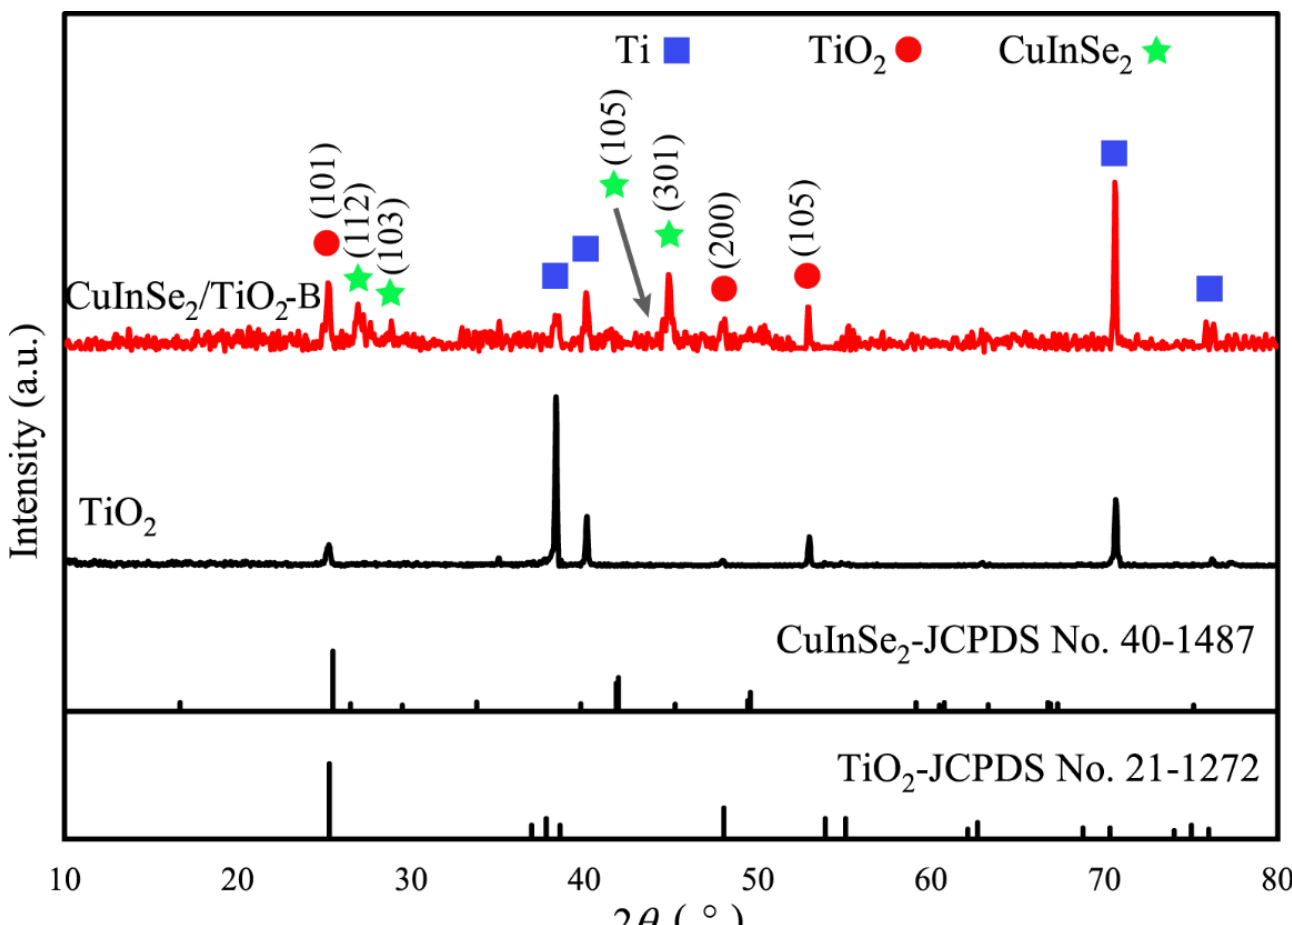
Figure 3. XRD patterns of TiO 2 and CuInSe 2 /TiO 2 ‐ B.